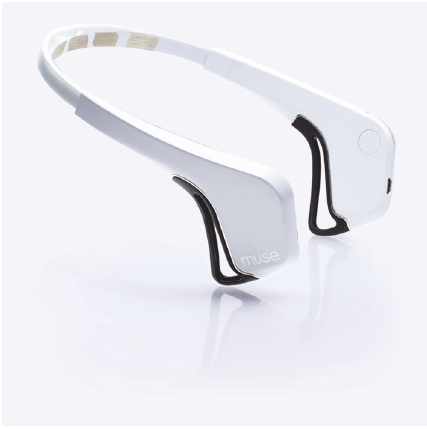
Figure 6: Brain sensing headband with embedded neurosensors (source: